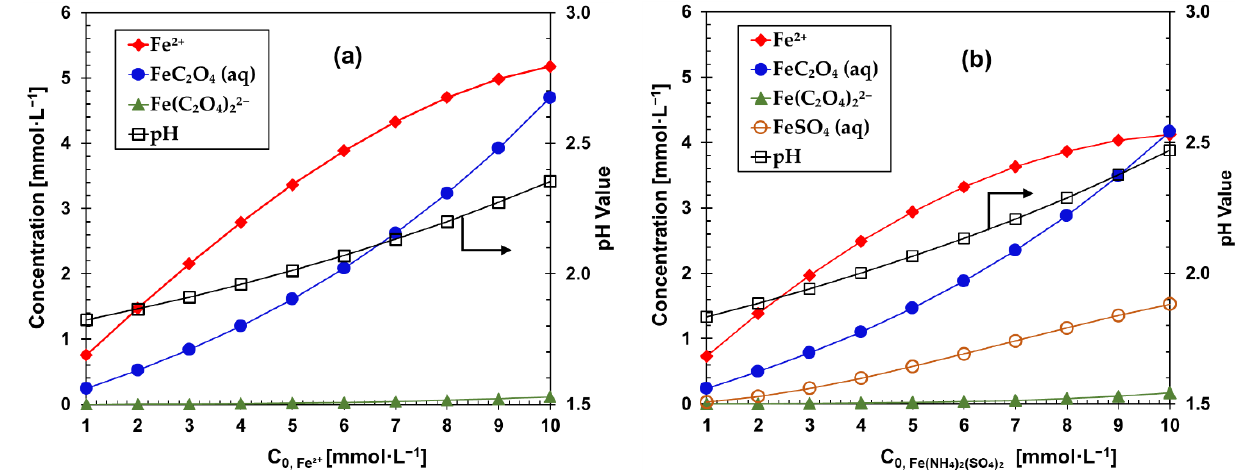
Figure 1. Comparison of the equilibrium calculations of ferrous oxalate concentration for two different dissolution systems at a constant oxalic acid concentration of 20 mmol·L − 1 and at 25 °C: ( a ) reductive dissolution of Fe 3 O 4 ; ( b ) simple dissolution of Fe(NH 4 ) 2 (SO 4 ) 2 powder.